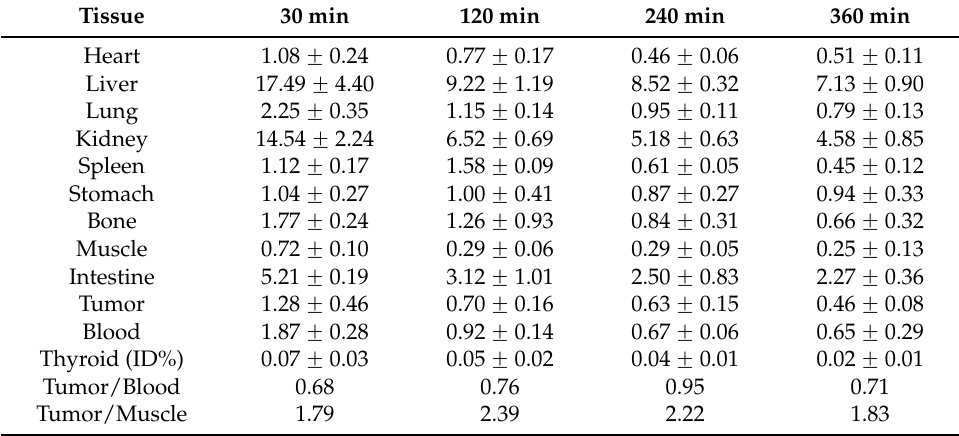
Table 2. Biodistribution of 7b in mice bearing S180 tumor (mean ˘ SD, n = 4, %ID/g).